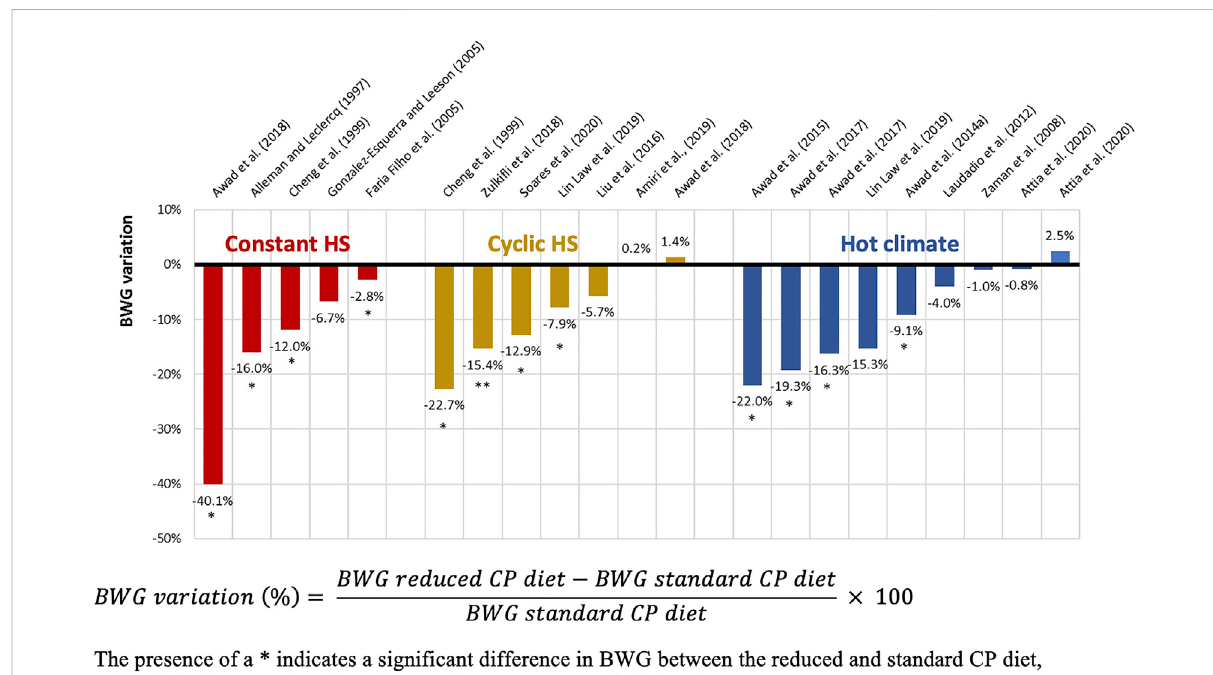
FIGURE 1 Effect of reduced and standard CP diets on BWG of broilers exposed to different HS